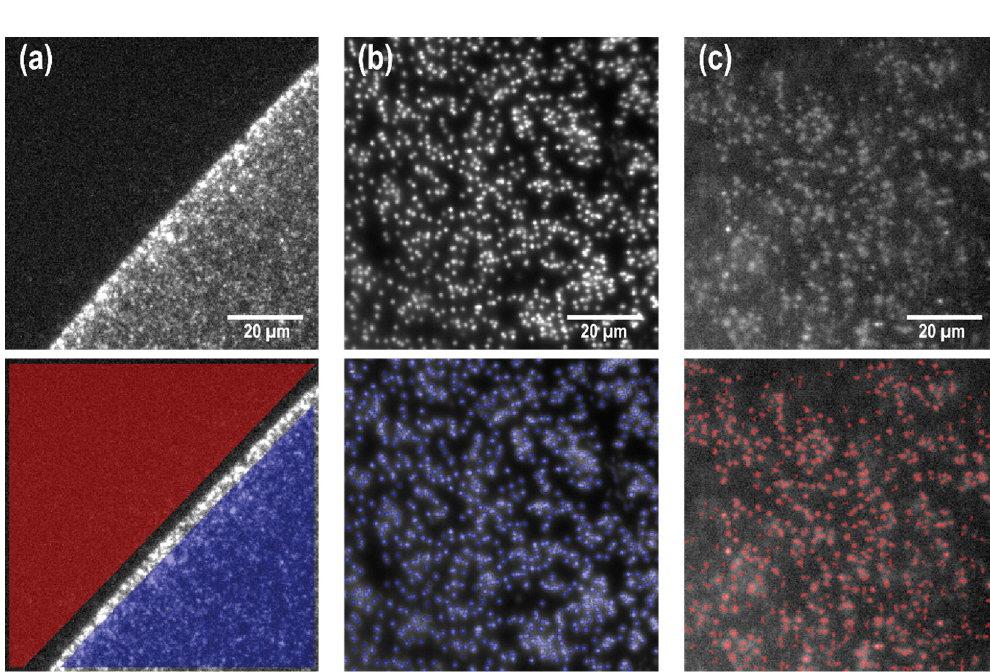
Figure 3. Image analysis for signal extraction on ( a ) MaxiSorp black polymer plastic spotted with antibodies and exposed to 0.4% serum concentration, ( b ) scFv-spotted nanowires exposed to 0.4% serum concentration, and ( c ) non-spotted nanowires exposed only to 0.4% serum concentration (control sample). Panel ( a ) is displayed in a different pixel window than panels ( b , c ) to better show the contrast between spotted and non-spotted areas in ( a ). On flat substrates, the signal and background intensity are extracted as the mean pixel value in the areas inside (blue) and outside (red) the scFv spot, respectively. On nanowire samples, I s is the mean pixel intensity on nanowire positions, (highlighted in blue in ( b )). Similarly, I B is the mean pixel intensity on nanowire positions on the control substrate (red in ( c )).